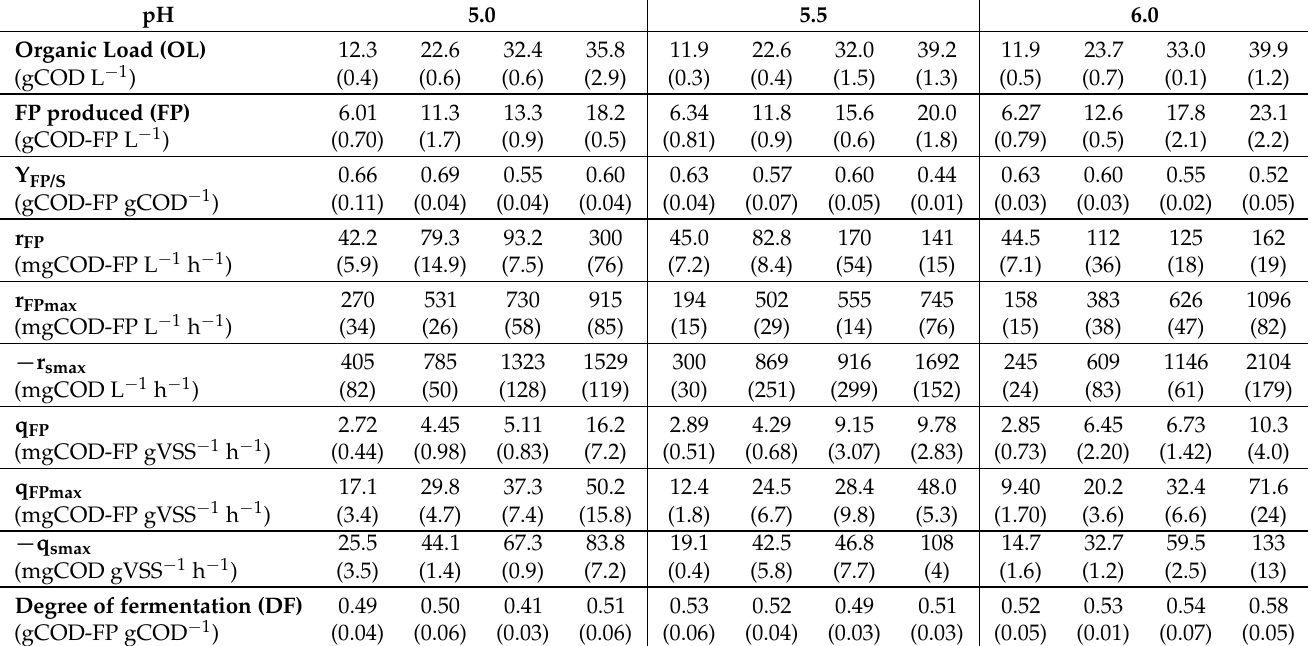
Table 4. Summary of the results obtained for each acidogenic batch assay. The values listed are averages ± standard deviation (values in